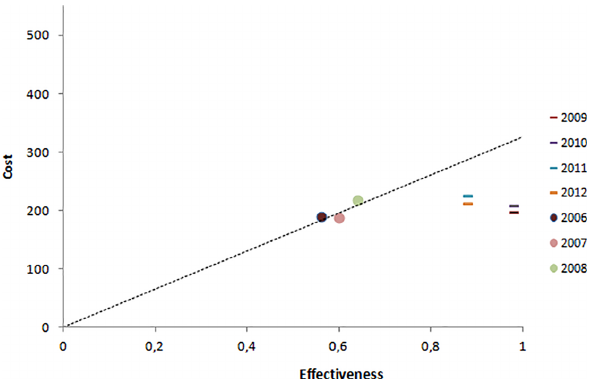
Fig 2. Cost-effectiveness threshold based on the pre-PC cost-effectiveness trend